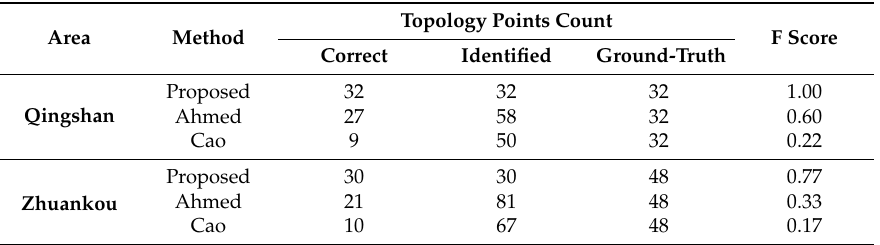
Table 3. Topology point